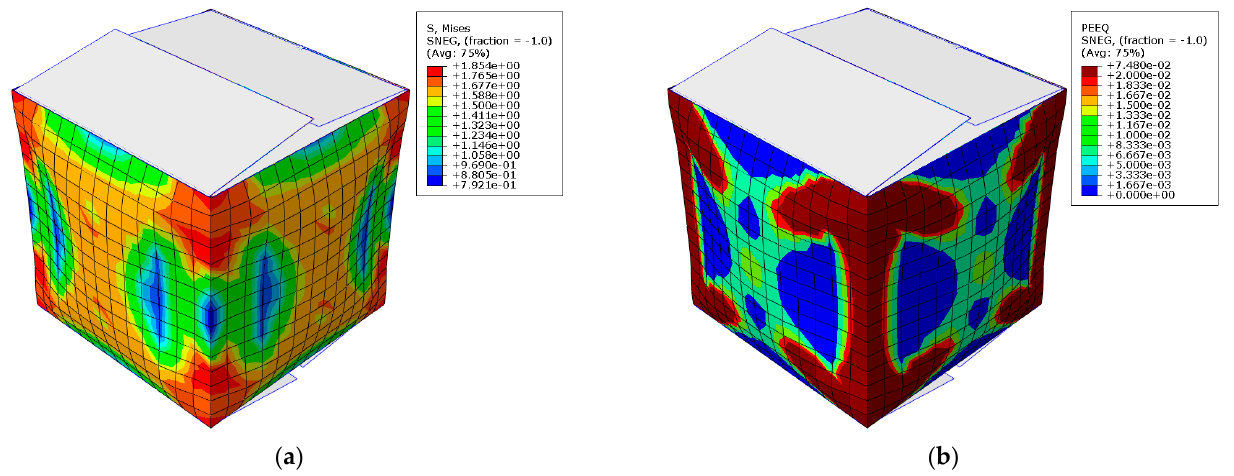
Figure 12. FE results in terms of: ( a ) Mises stresses and ( b ) equivalent plastic strains.